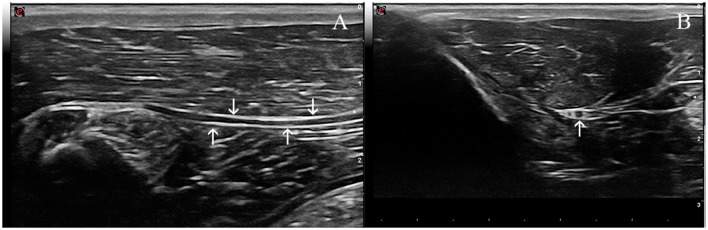
Ultrasound images of the sciatic nerve in the rabbit. (A) Longitudinal ultrasound image of this nerve (arrows), which appears as a tubular hypoechoic structure, outlined by hyperechoic lines (arrows). (B) Transverse ultrasound image of the sciatic nerve. The two components of this nerve are readily distinguished and appear as two ovoid hypoechoic structures surrounded by a thin hyperechoic rim; the smaller and more cranial one representing the common peroneal nerve, and the larger and more caudal the tibial nerve (arrow).